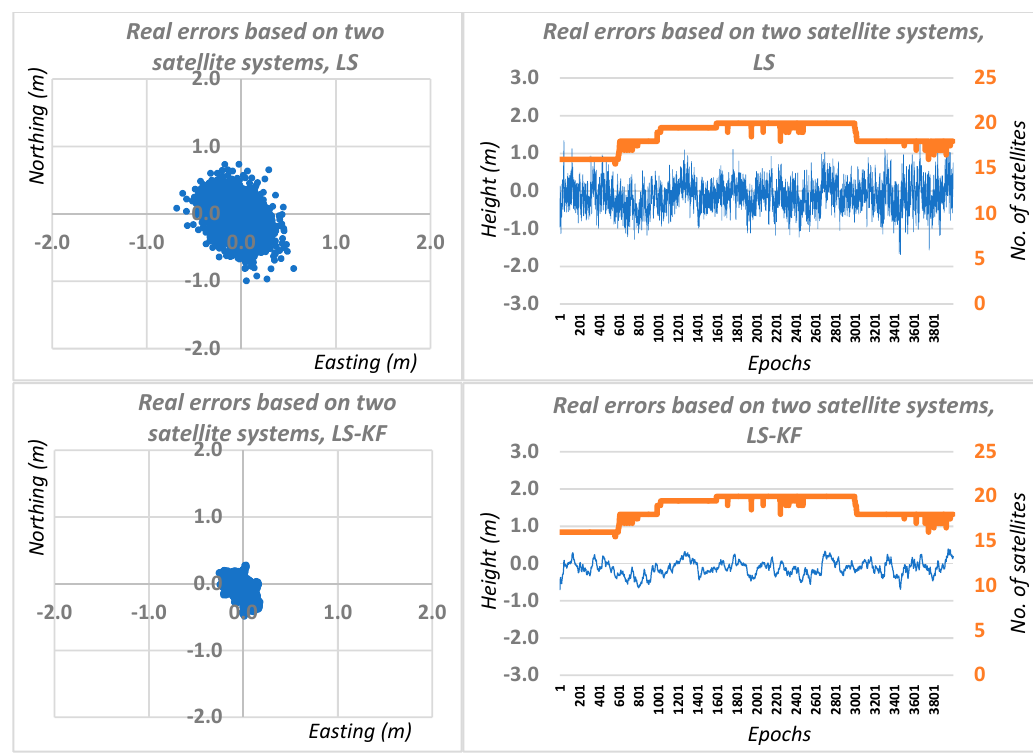
Figure 6. Real errors of the simulated network DGNSS positioning based on least squares solutions and Kalman filtering for two GNSS systems.